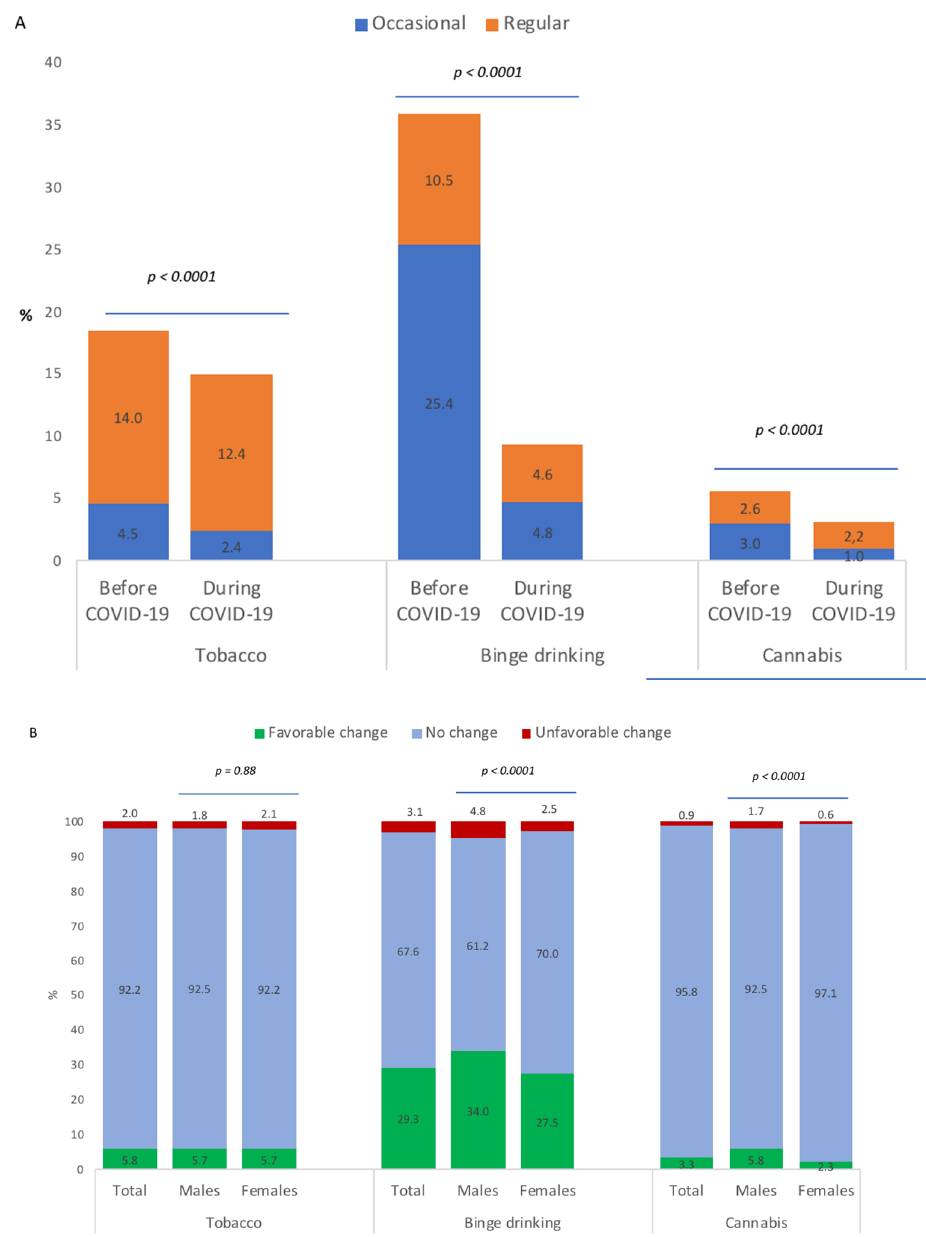
Figure 2. Tobacco smoking, binge drinking and cannabis use of university students before and during COVID-19 ( A ) and changes in behavior between the periods before and during COVID-19 ( B ).